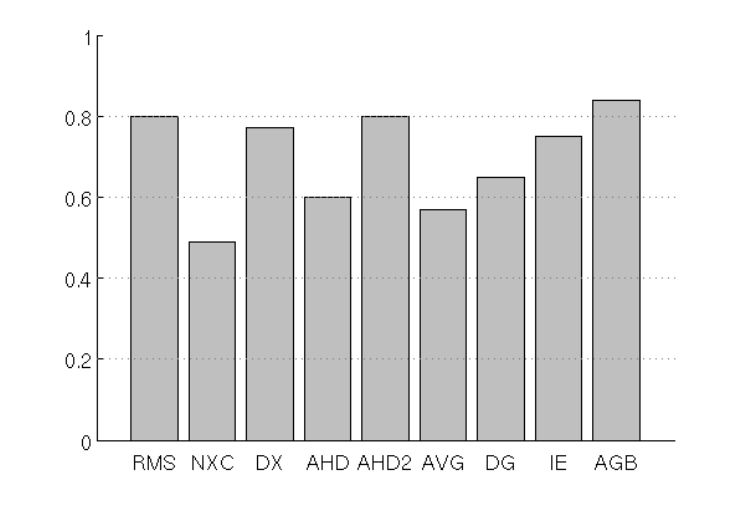
Figure 10. Fraction of passed monotonic tests for the NaN -translation